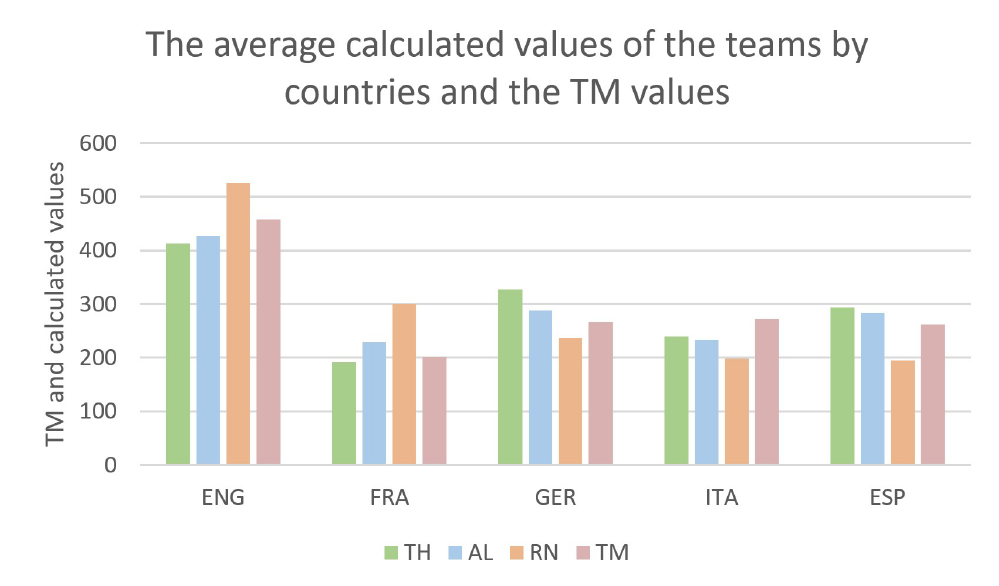
Figure 4. Estimated values and real average Transfermarkt (TM) values of the teams by